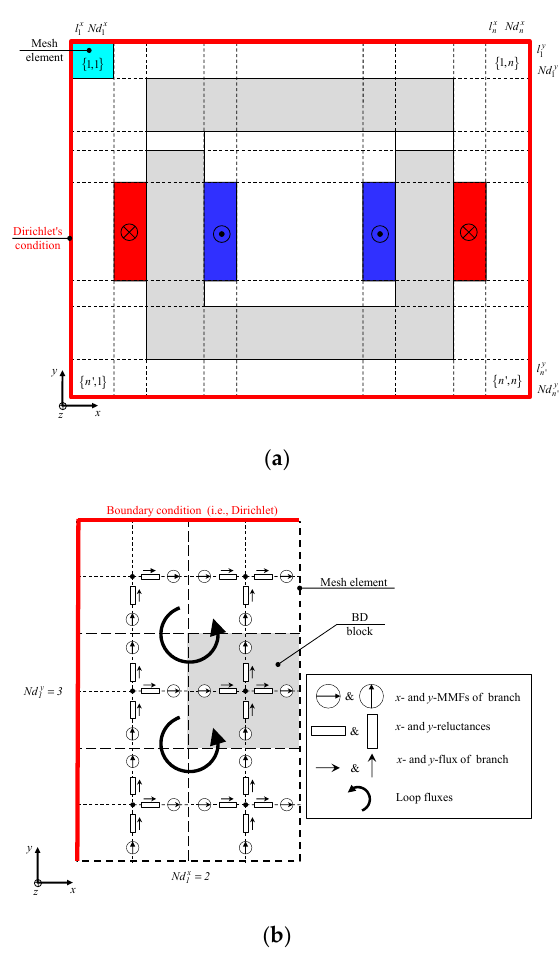
Figure 3. Generalized discretization of a U-cored static electromagnetic device: ( a ) Automatic mesh, and ( b ) discretization of a mesh element (e.g., for the mesh element { } 1,1 ). The mesh elements are so composed of BD blocks depending on the discretization chosen by the { } 1,1 (see the mesh designer. Figure 3b describes an example of discretization for the mesh element 2 = x Nd and 3 = y Nd , where the number of BD blocks element in sky blue color in Figure 3a) with 1 is equal to 6 × = x y Nd Nd . The BD blocks, connected between them by the loop fluxes ψ and giving to the magnetic flux the possibility to flow in both directions, are described by a middle-point related to (except for the outer edges of the device due to Dirichlet’s conditions): •